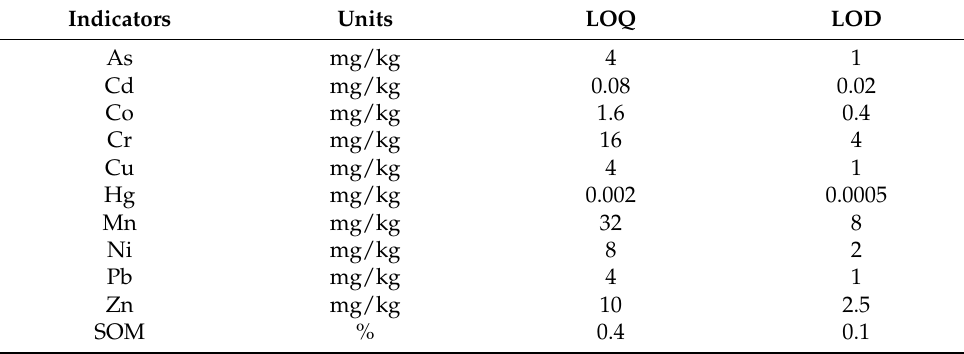
Table 1. The limits of soil